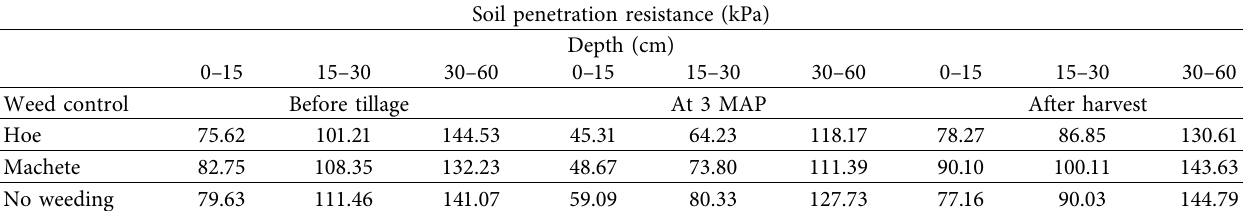
Table 7: Weed control Method’s effect on soil penetration